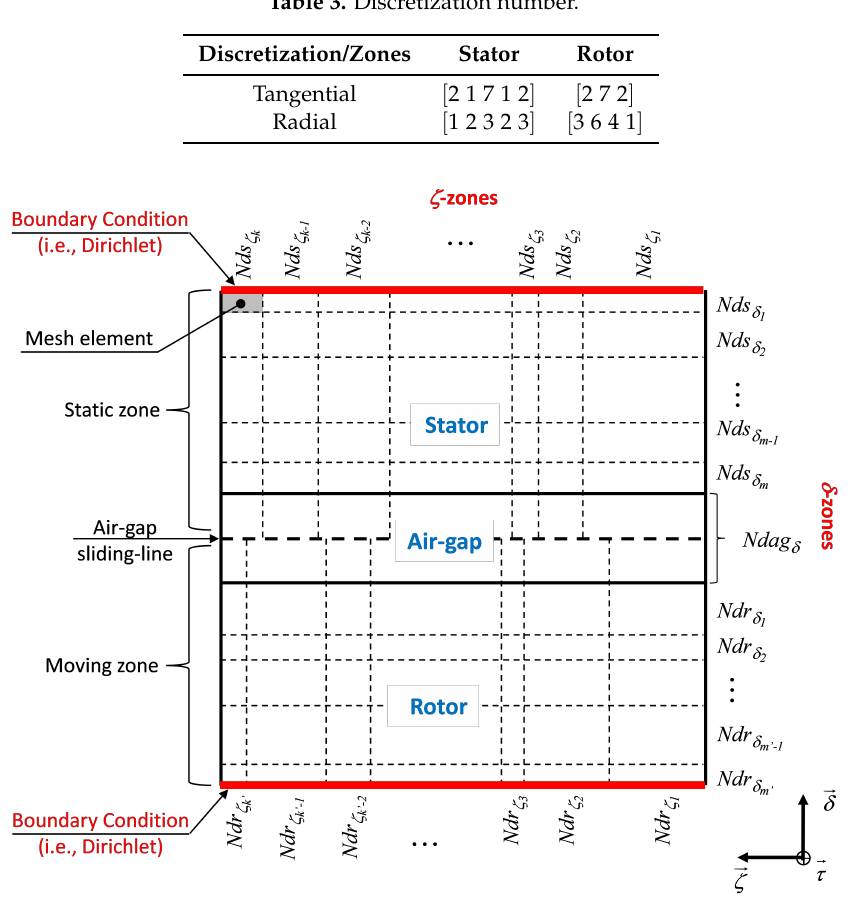
Figure 4. Mesh element discretization